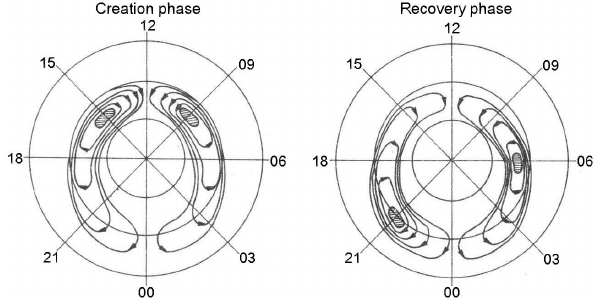
Figure 29. Schemes of ionospheric convective motion during the creation and recovery phase of substorms obtained from data con- cerning the motions of discrete auroral forms (Vorobjev et al.,